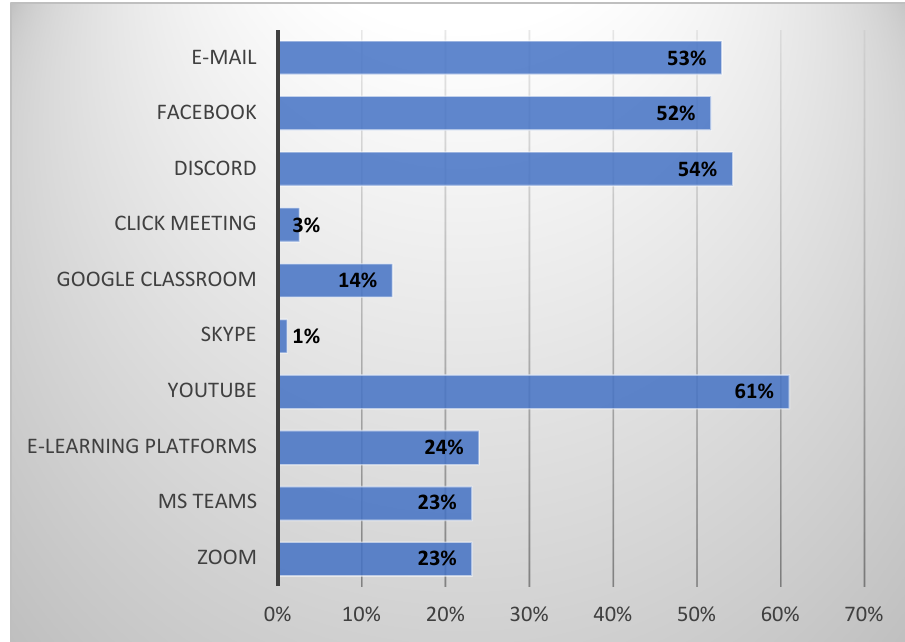
Figure 1. Percentage of students familiar with a given e-learning tool before the COVID-19 pandemic.